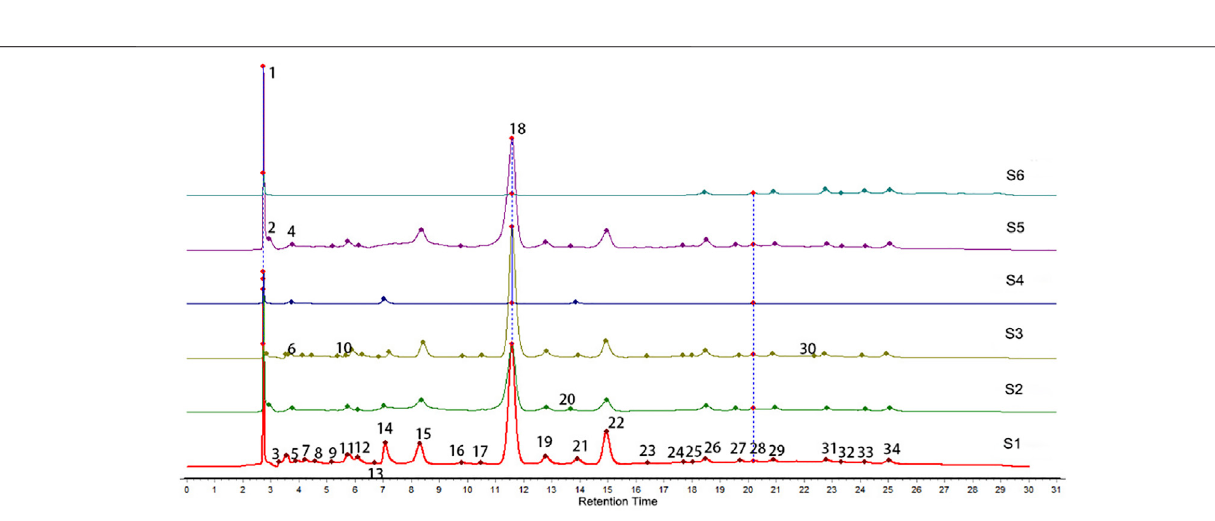
FIGURE 1 | The chromatogram of the total extract obtained by conventional decocting (water) of C. nudi fl ora leaves.